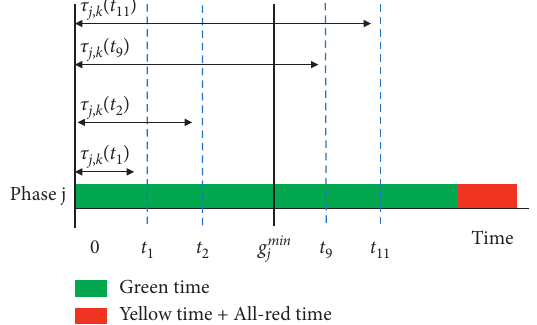
Figure 3: Minimum green time